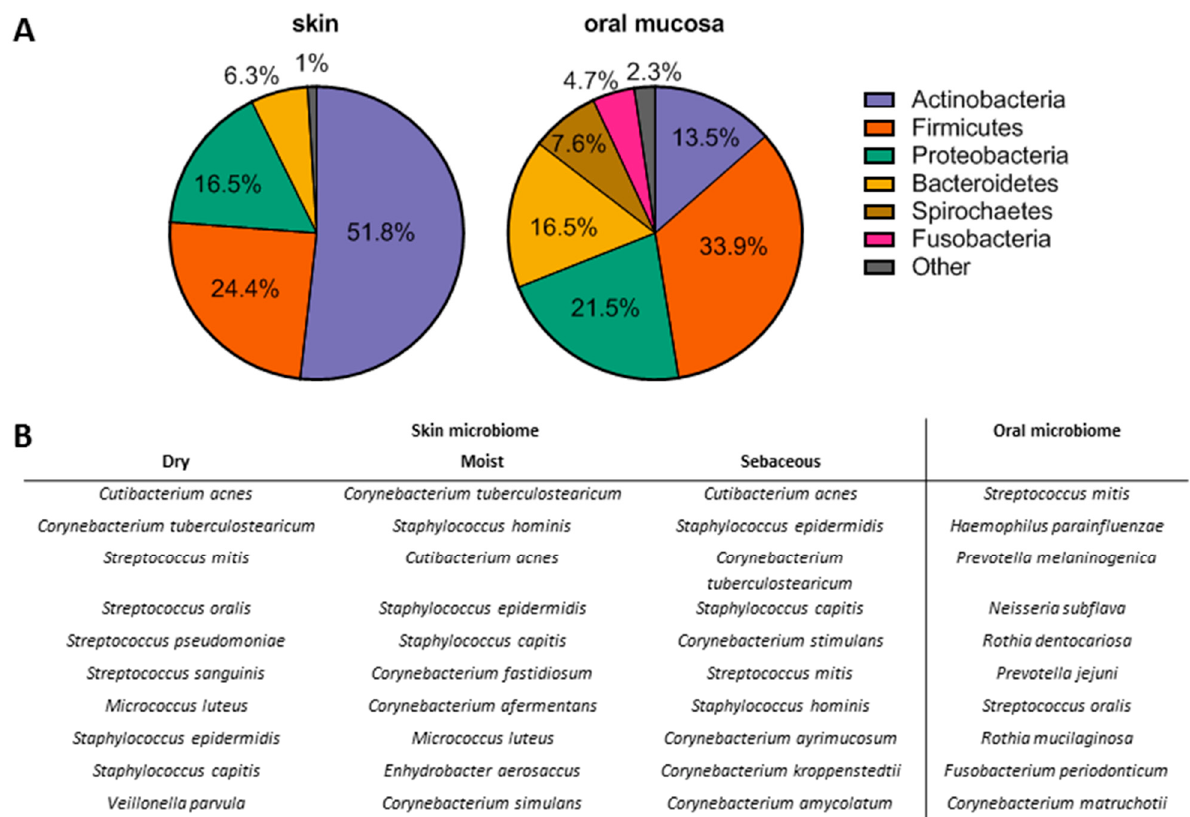
Figure 3. The microbiome in healthy skin and oral mucosa. ( A ) Dominating bacterial phyla in skin and oral mucosa; ( B ) most common bacterial species in skin and oral mucosa [33,37,40].